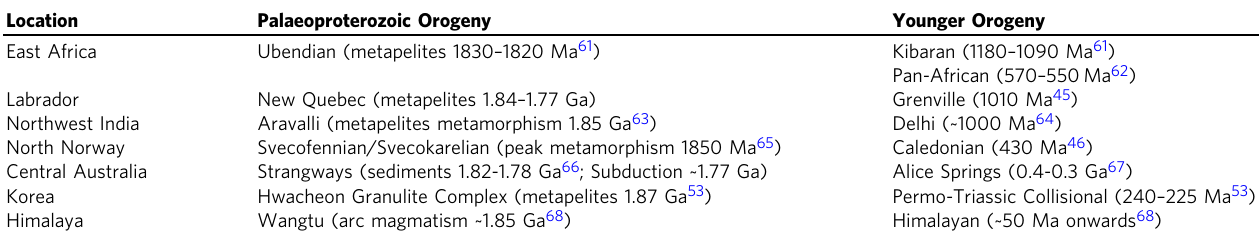
Table 2 Examples of reworking of Palaeoproterozoic metapelites during deformation in younger orogenies (Fig.